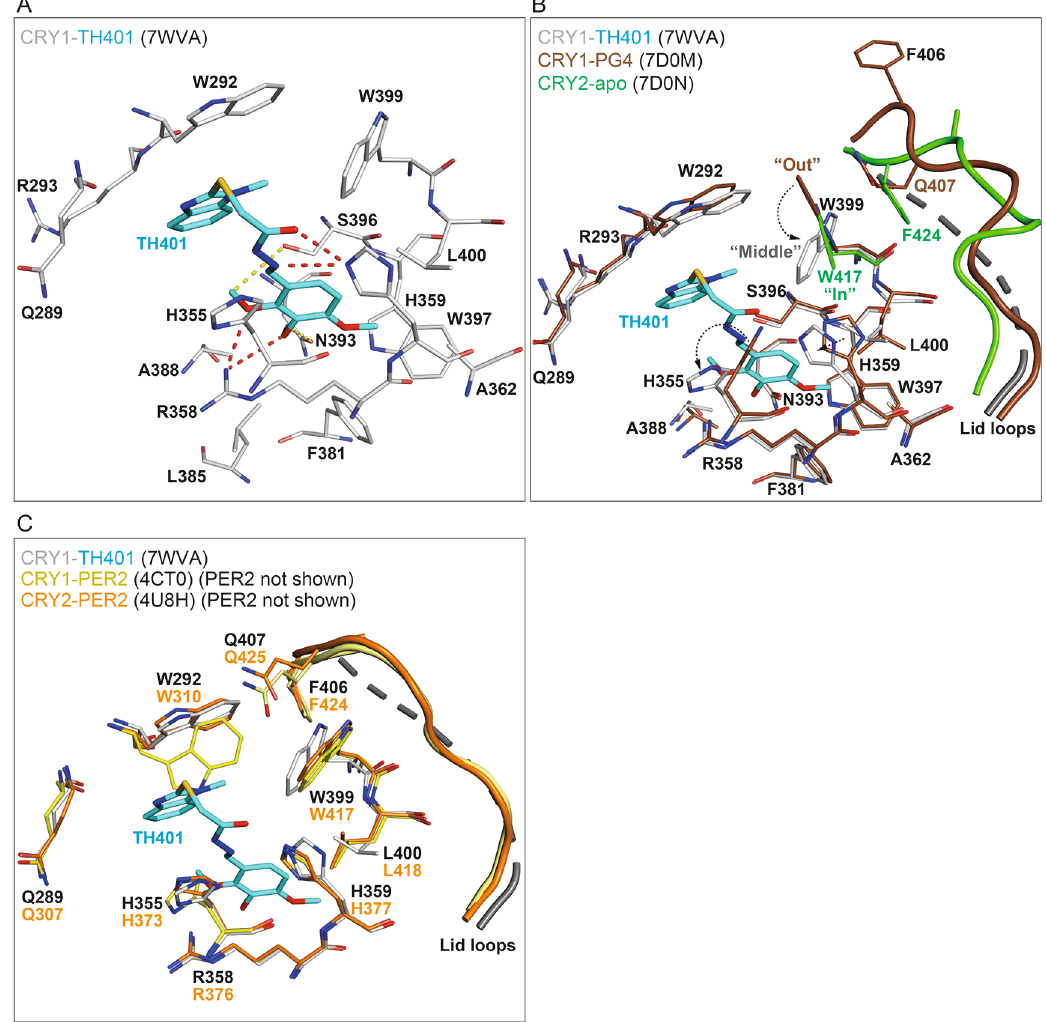
Figure 3. Crystal structure of CRY1-TH401 (PDB: 7WVA). (A) The binding mode of TH401 in CRY1. Flavin adenine dinucleotide (FAD) pocket residues (white) that interact with TH401 (cyan) are shown. Hydrogen bonds and C – H hydrogenbondsarerepresentedbyredandyellowdashes,respectively.(B)TH401inducedconformationalchanges in the FAD pocket of CRY1. Superposition of CRY1-TH401 (white-cyan) onto CRY1-PG4 (brown) (PDB: 7D0M; PG4, a non-biological tetraethylene glycol cryoprotectant, is not shown) and CRY2-apo (green) (PDB: 7D0N). Only the gatekeeper – lidloopinterface isshown in CRY2-apo forsimplicity. Thebinding of TH401 resulted in the repositioning of the gatekeeper W399 from an intrinsic “ out ” conformation in CRY1-PG4 (apo-like structure) to a “ middle ” conformation in CRY1-TH401. The W399 “ middle ” conformation resulted in the loss of an NH – aryl interaction between W399 and Q407 at the gatekeeper – lid loop interface in CRY1-PG4. Additional flexibility in the lid loop of CRY1 with bound TH401 meant the lid loop was not built into the crystal structure and its predicted structure is represented as dashed lines as modeled by Pymol. The intrinsic “ in ” conformation of the gatekeeper W417 in CRY2 would require a smaller conformational change to adopt a “ middle ” position than the intrinsic “ out ” conformation of W399 in CRY1. (C) Superposition of CRY1-TH401 (white-cyan) onto CRY1-PER2 (yellow) (PDB: 4CT0) and CRY2-PER2 (orange) (PDB: 4U8H). PER2 is not shown for simplicity. The binding mode of TH401 looks compatible with the key FAD pocket residues H355 and W399 in CRY1-PER2, corresponding to CRY2-PER2 residues H373 and W417, caused a loss of activity, consistent with the interactions of the methyl group with W399, and the ortho -methoxy group with R358 and S396 (Figure 3A). Modifications to the trimethoxy groups of the trimethoxyphenyl resulted in either weak activity (TH404-TH406) or inactivity (TH407-TH411), supporting their interactions with R358, S396, and N393, as well as A362, F381, L385, A388, W397, and L400. The weak activities of TH404-TH406 suggested that an interaction of the ortho -hydroxy group with R358 can support activity. Therefore, CRY-TH401 interactions in the crystal structure are consistent with activity in cells.